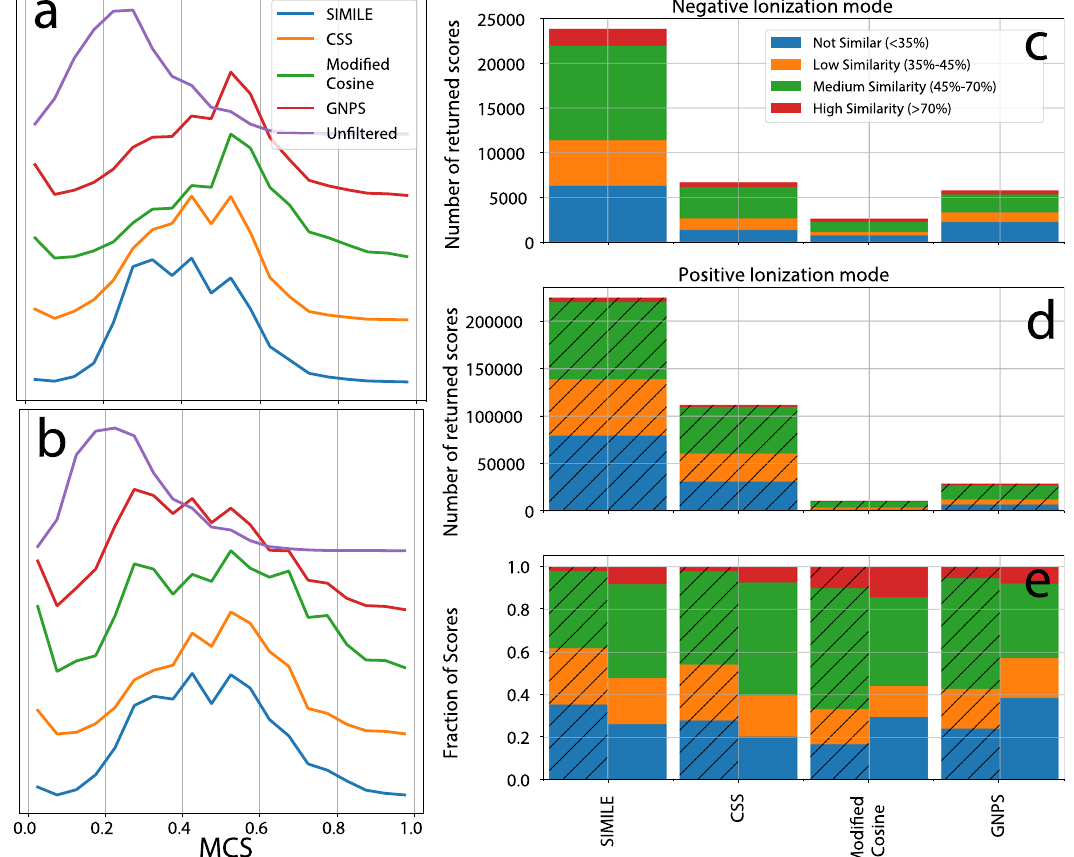
Fig. 3 SIMILE identi fi es more pairs of spectra with meaningful structural similarity in comparison with Core Substructure Search (CSS), GNPS, and Modi fi ed Cosine using maximum common substructure (MCS) as a proxy for structural similarity. The inset histograms ( a and b ) show the distribution of MCS for un fi ltered pairs of spectra and the MCS distribution for each algorithm in positive and negative ionization modes (respectively). The number of pairs with low, medium, or high structural similarity are shown for each algorithm in ( c and d ); and the fraction of similarity scores by each approach in ( e ) where positive ionization mode — dashed lines and negative ionization mode are solid